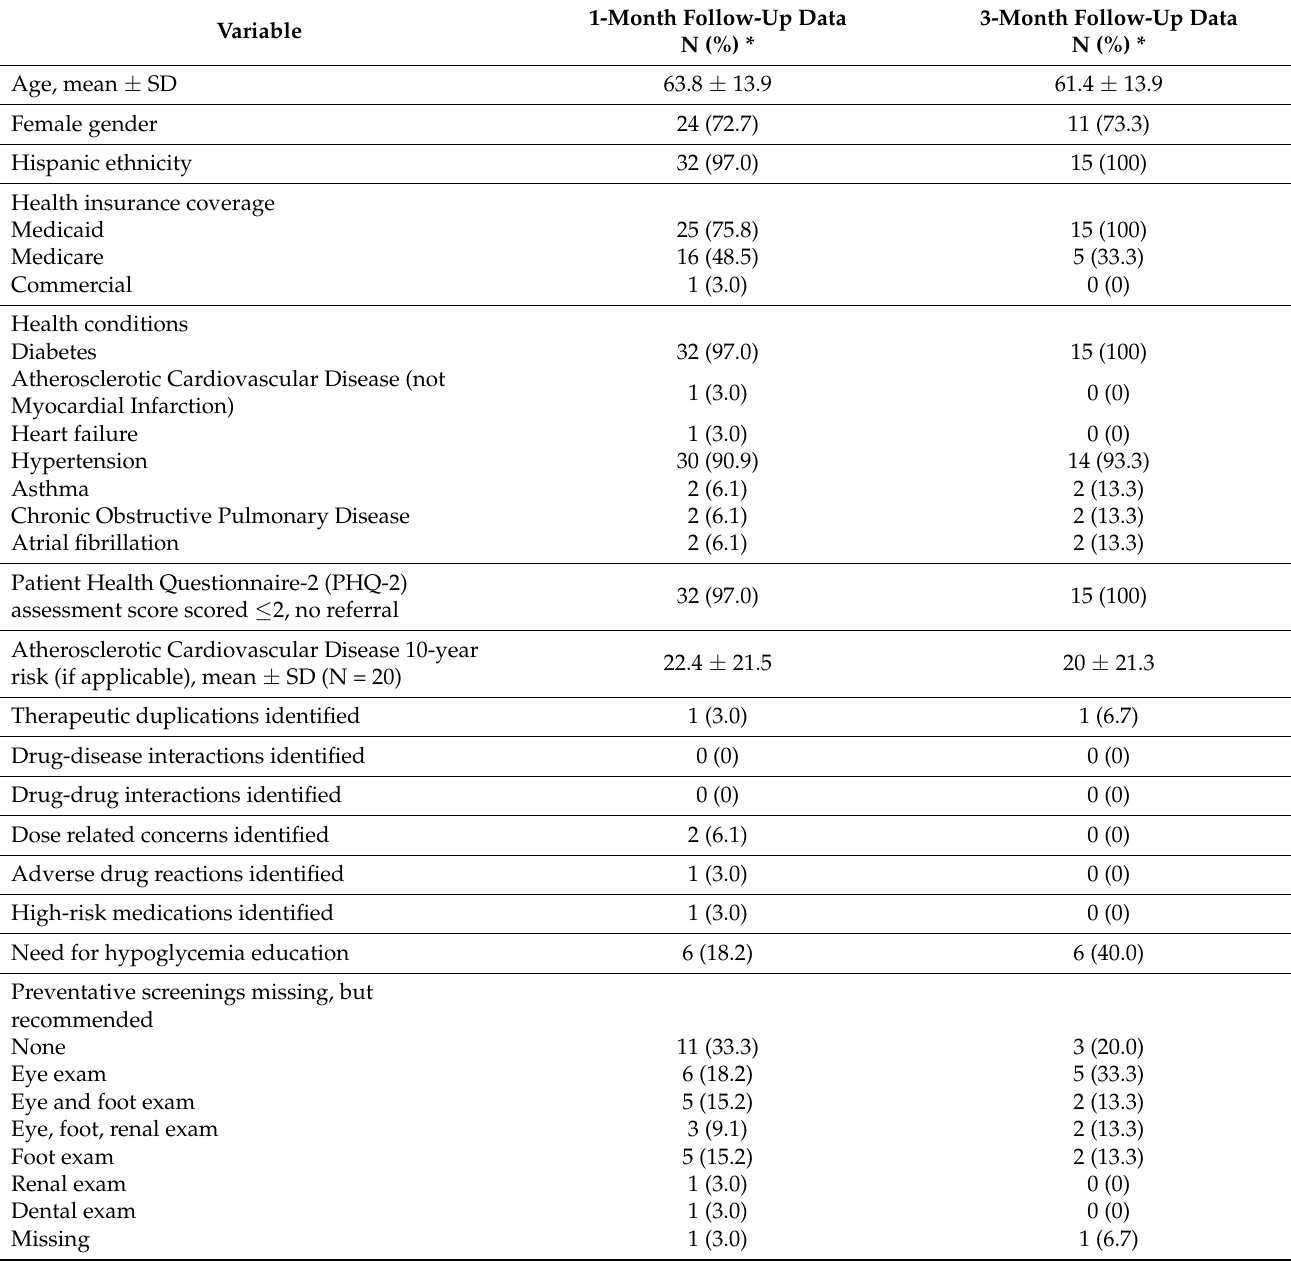
Table 1. Demographic characteristics of patients with baseline and 1-month follow-up data ( n = 33) and 3-month follow-up data ( n =